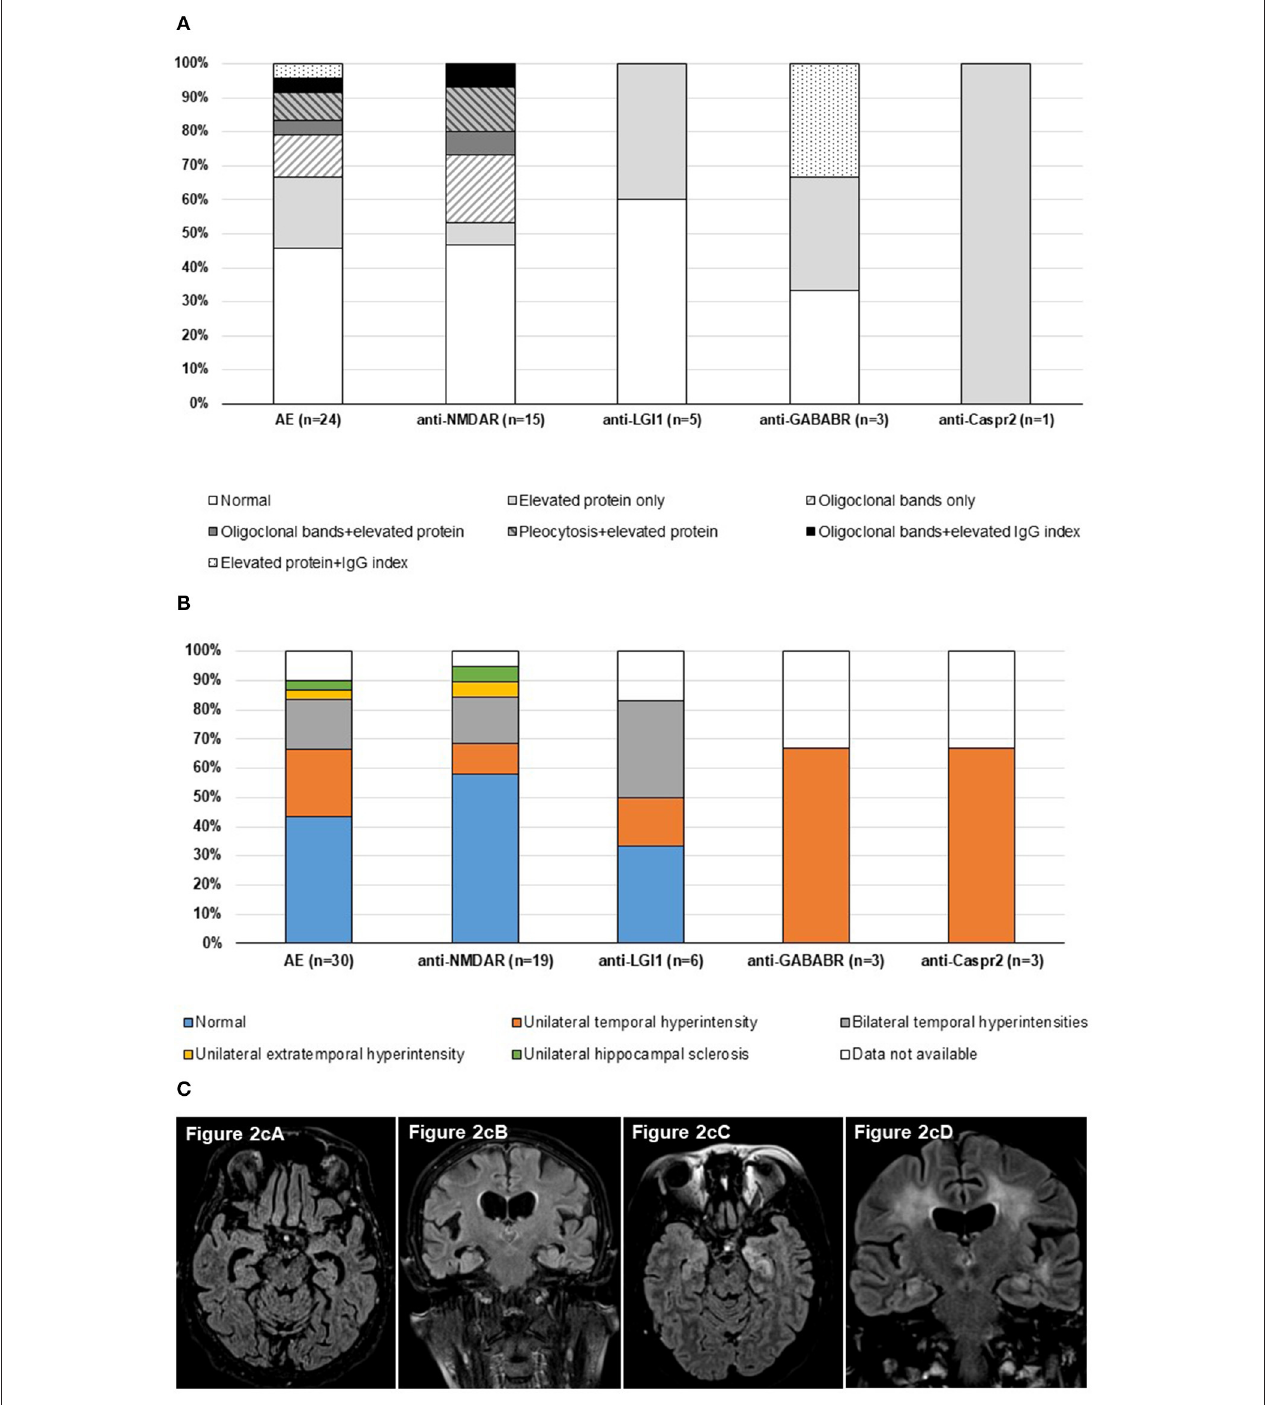
FIGURE 2 | (A) Composition of cerebrospinal fluid in AE patients. The bars demonstrate CSF analyses result of 24 AE patients from our cohort. At least one abnormal CSF finding was found in 13 AE patients, most commonly in anti-NMDAR and anti-GABABR patients. Pleocytosis and OCB were detected only in NMDAR encephalitis. (B) Brain MRI findings in AE patients. The diagram shows brain MRI result of 27 AE patients from our cohort. In 14 AE patients, abnormalities were found, mainly in the form of unilateral or bilateral temporal hyperintensities. (C) Axial and coronal FLAIR brain images from patient 8 (cA, cB) and patient 24 (cC, cD). Patient 8 was a 75-year-old female patient, who had anti-NMDAR autoantibody positivity detected in CSF and had hyperintensity and contrast enhancement within bilateral medial temporal lobes (cA-axial 3D FLAIR, c B-coronal T2 FLAIR). Patient 24 was a 50-year-old female patient, who had anti-LGI1 autoantibody positivity detected in serum and had bilateral limbic encephalitis, dominant in the left temporal lobe, both on axial (cC) and coronal T2 FLAIR images (cD).